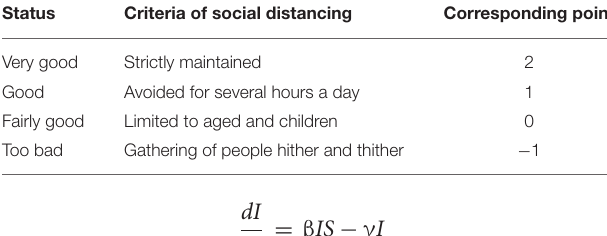
TABLE 3 | Social distancing status on a rating point ( − 1– + 2).